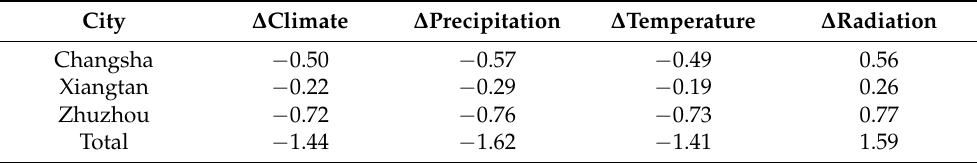
Table 2. The effects of climate changes, precipitation, temperature, and radiation on the total production (T gC) in the CZT urban agglomeration from 2000 to 2015. ∆ Climate, the effect of climate changes; ∆ Precipitation, the effect of precipitation changes; ∆ Temperature, the effect of temperature changes; ∆ Radiation, the effect of radiation changes. City ∆ Climate ∆ Precipitation ∆ Temperature ∆ Radiation Changsha − 0.50